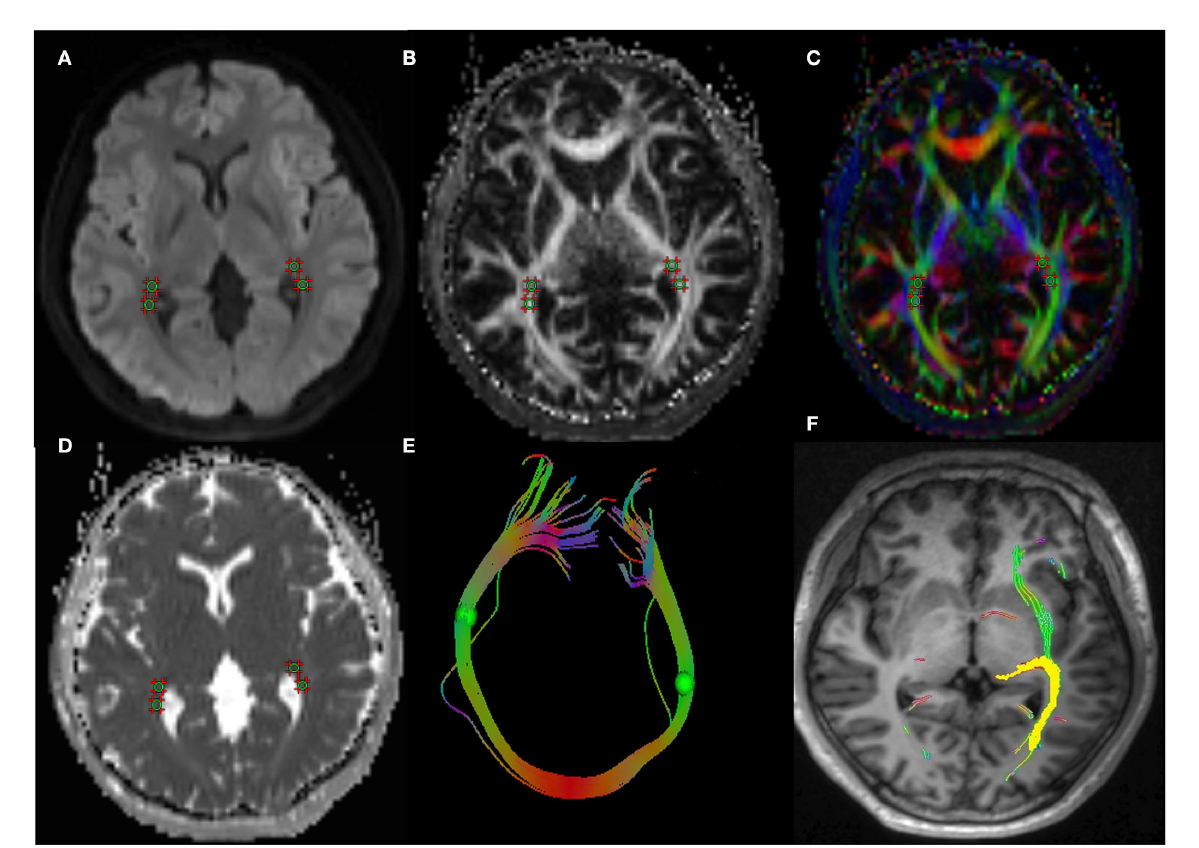
FIGURE1 A 43-year-old woman with TAO. Schematic diagrams for measurements of visual pathway on DTI. Figure (A–D) showed the axial TRACEW, FA maps, color FA, and ADC. (E) showed an “open-loop structure” consisting of bilateral optic radiation white matter fibers and splenium of corpus callosum. (F) showed the visual pathway white matter fiber tractography, the yellow stands for the track result of LG, it shows the subcortical pathway reaching primary visual cortex through the optic radiation. A circle region of interest was manually set on LG and OR, with careful avoidance of surrounding tissues. Fiber tractography was then carried out to confirm correct placement of ROI. TAO: thyroid-associated ophthalmopathy, DTI: diffusion tensor imaging, FA: fractional anisotropy, ADC: apparent diffusion coefficient, LG: lateral geniculate, OR: optic